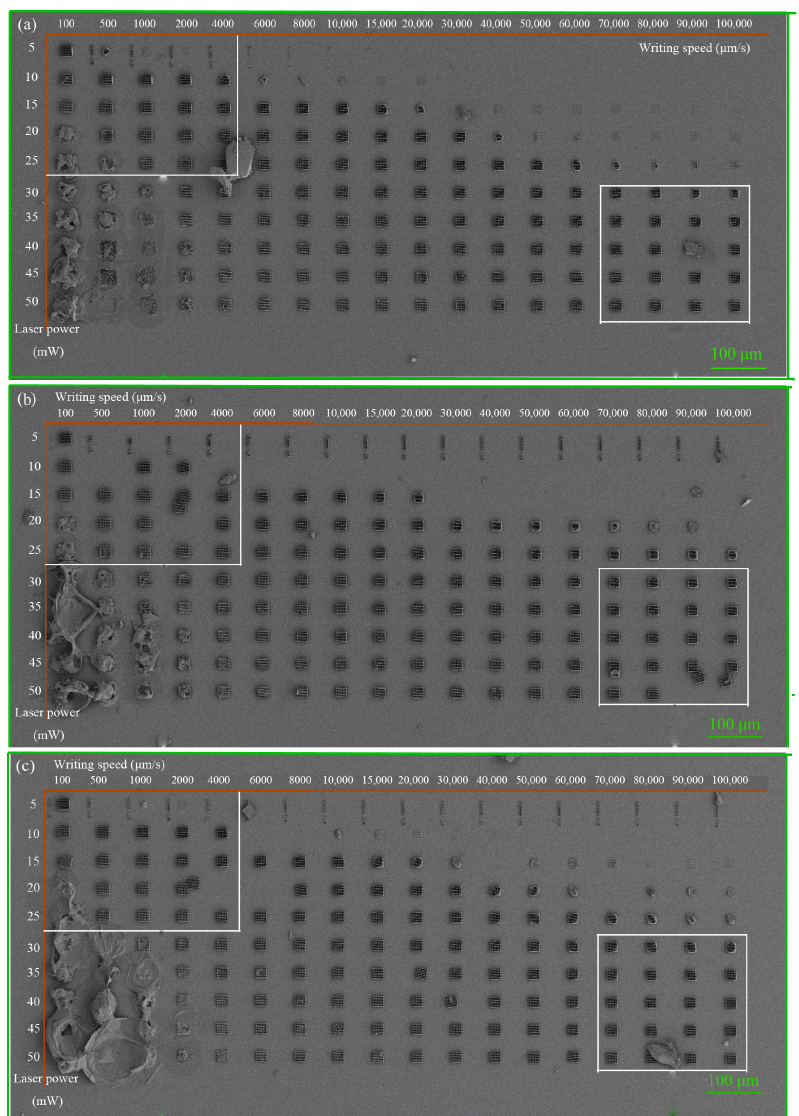
Figure 8. SEM images of structures with initiators ( a ) BM-PPPM-C12; ( b ) BM-PPPM-C16; and ( c ) BM-PPPM-C20 in TMPTA, 10 μ mol/g.